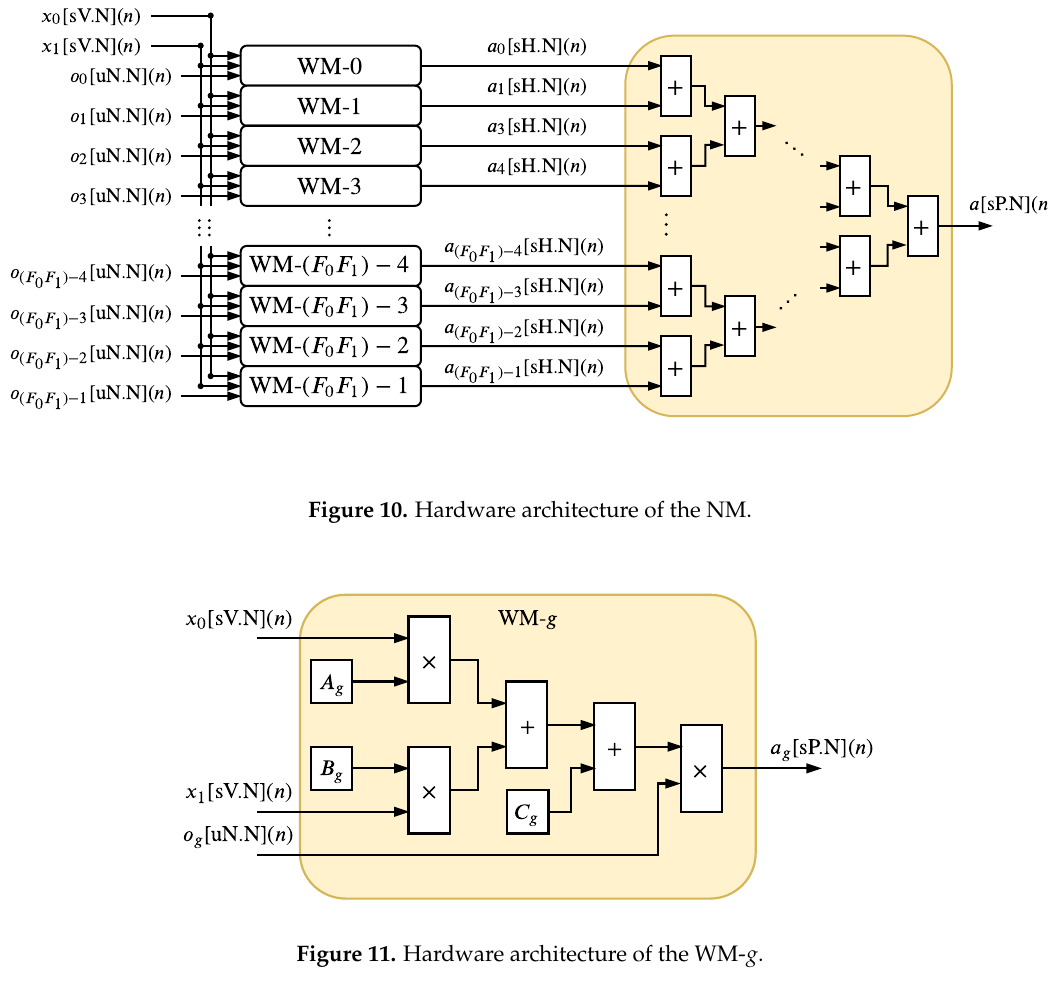
Figure 11. Hardware architecture of the WM- g